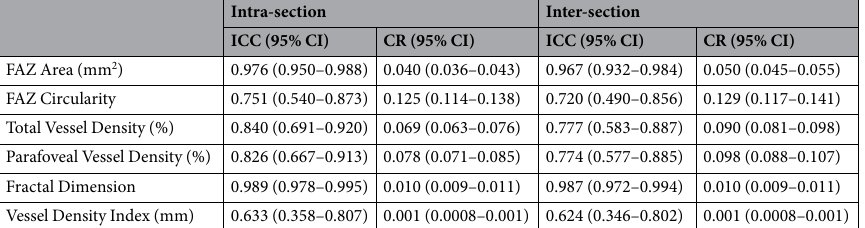
Table 2. Reliability estimates of quantitative optical coherence tomography-angiography (OCT-A) metrics measurements using an automated analysis program in a subset of 30 eyes from 30 diabetic participants. Two OCT-A scans were acquired during first visit for these participants for intra-session repeatability assessment. These 30 patients were also invited for another visit for OCT-A scan within 2 weeks for inter-session reproducibility assessment. CR: Coefficient of repeatability; FAZ: Foveal avascular zone; ICC: Intra-class correlation